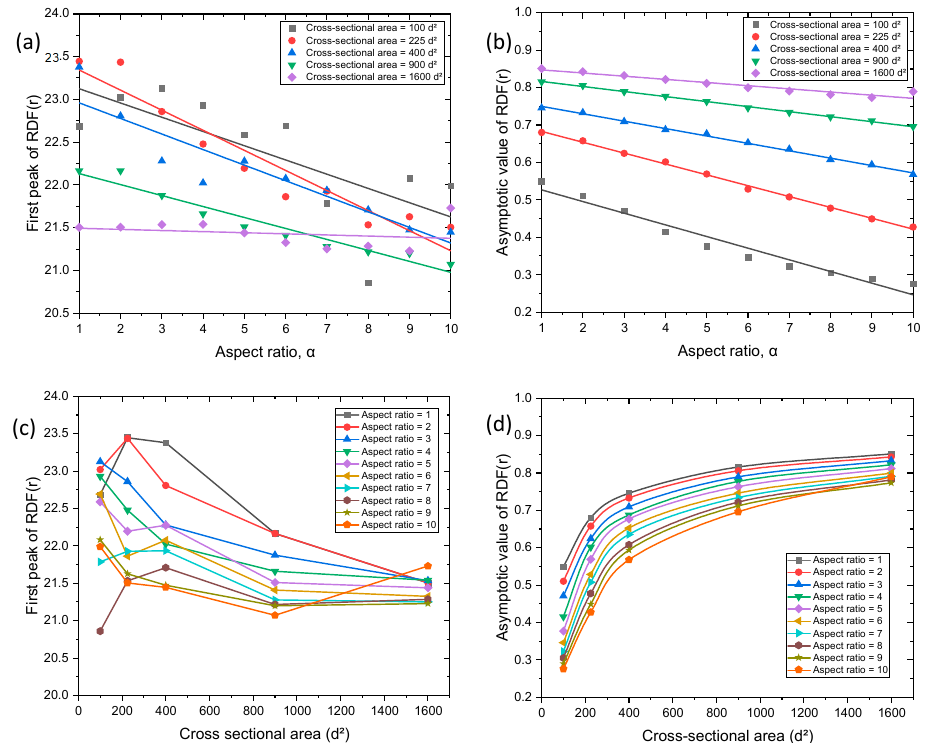
Figure 19. First peak value and asymptotic value of the RDFs of the rectangular pebble beds depend on ( a , b ) aspect ratios and ( c , d ) cross-sectional areas.